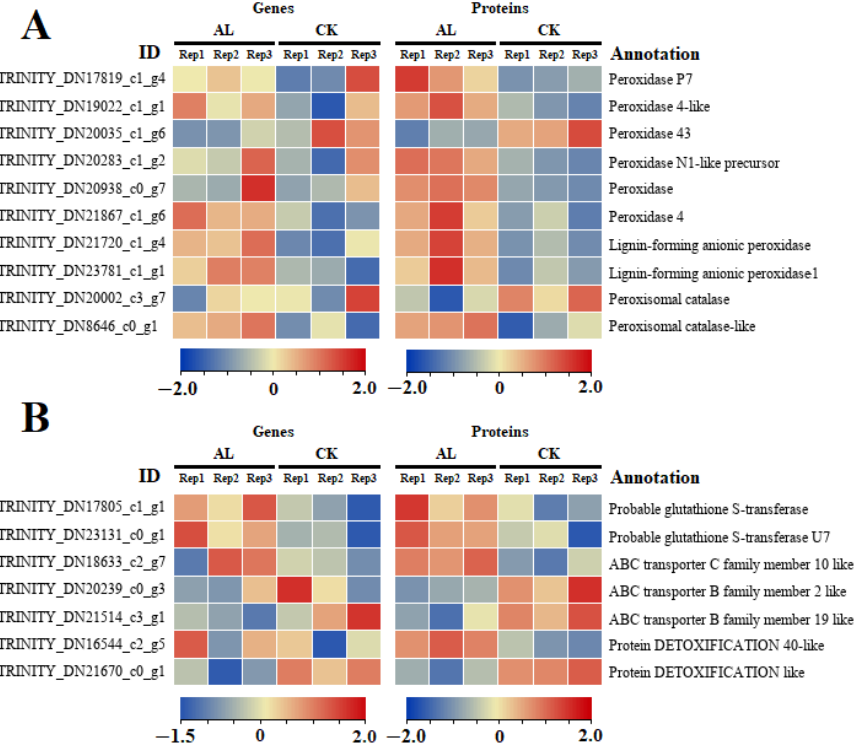
Figure 6. Heat-map analysis of the differentially expressed proteins involved in antioxidation ( A ) and anthocyanin transport ( B ).